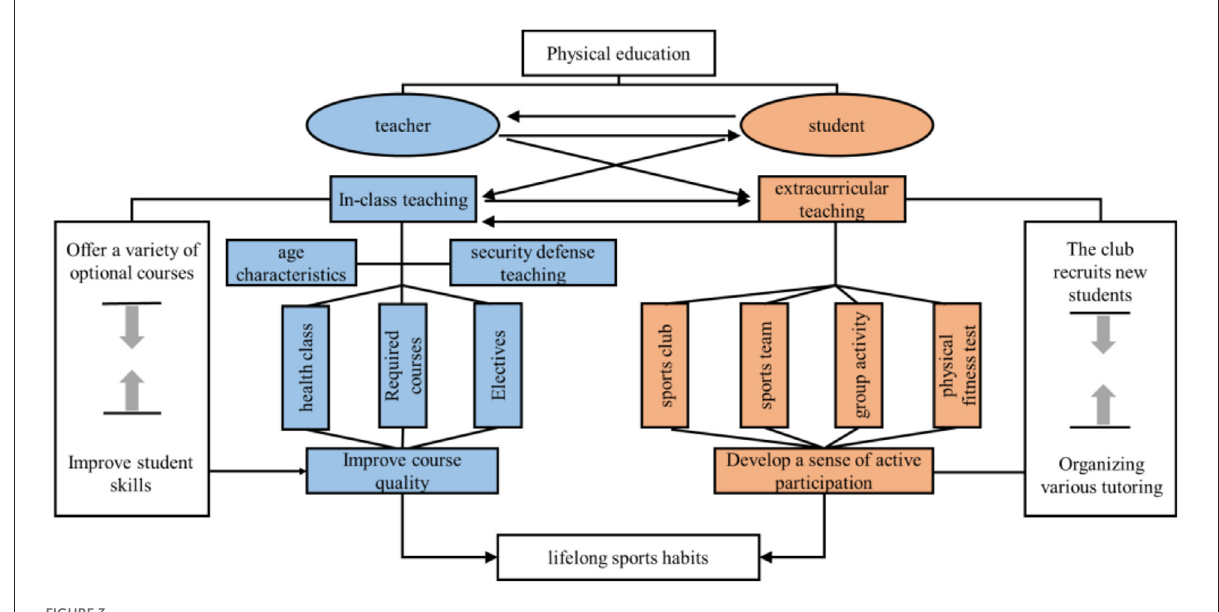
FIGURE3 The lifelong physical education teaching mode runs through it.